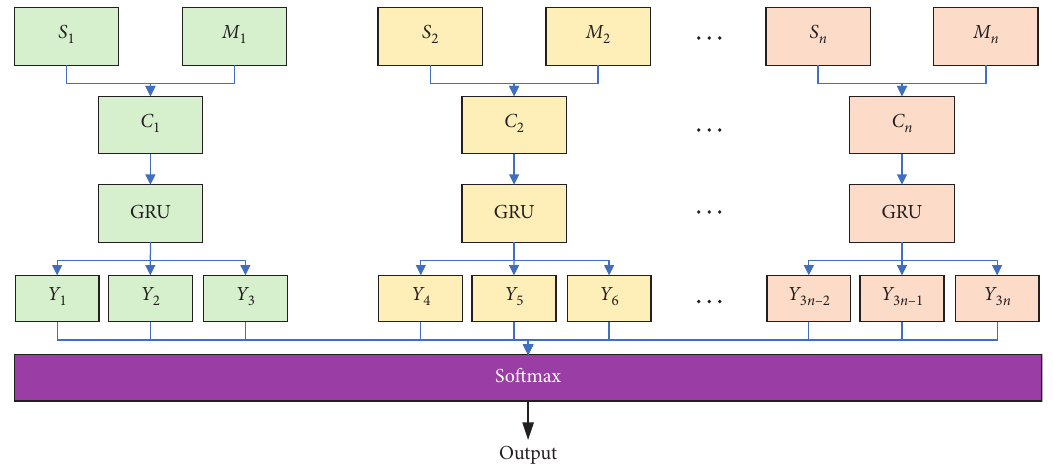
Figure 2: GRU-based video character classification model. Table 1: Comparison of the accuracy of multipoint grid supervision.